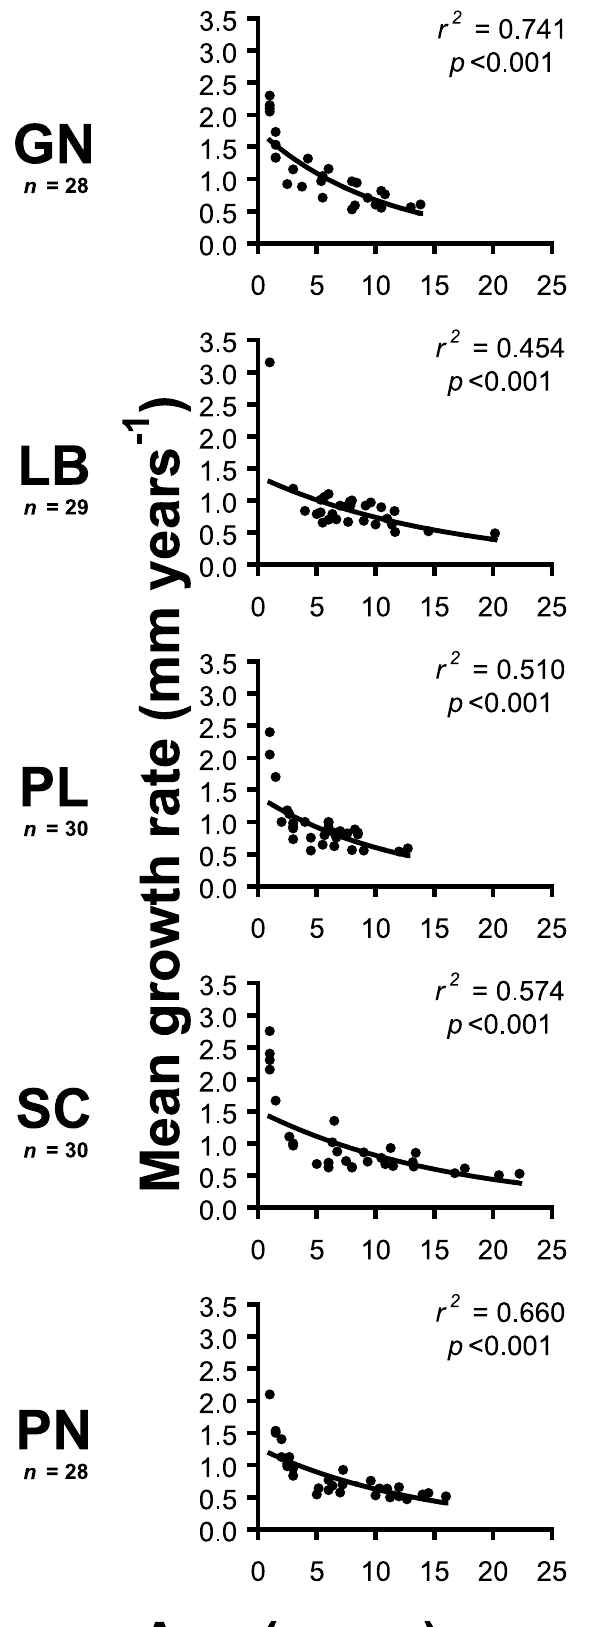
Figure 3. Relationships between mean growth rate and age of each population. Data were fitted with exponential curves to verify the exponential decrease of growth rate with age assumed by the von Bertalanffy growth model. n = number of individuals dated by computerized tomography scans